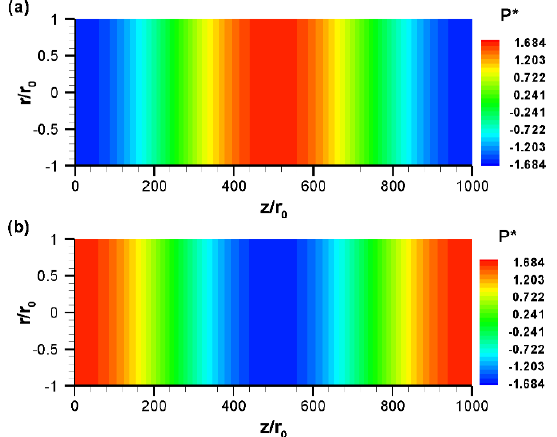
* P Pr u  , at different nondimensional 0 HS